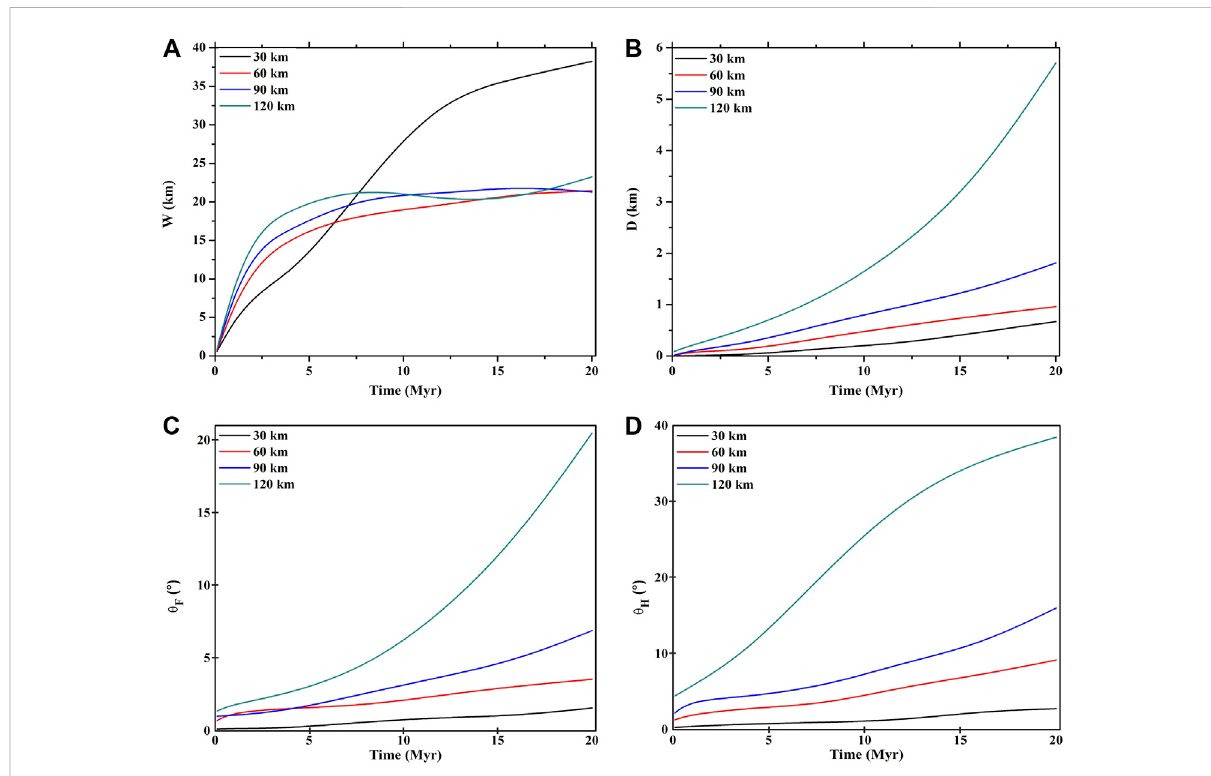
FIGURE 6 Time-dependentvariationsofthemajortopographicelementsoftrenches: (A) openingwidth(W), (B) maximumtrenchdepth(D), (C) FWslopes ( θ F), and (D) HW slopes ( θ H). The graph colors denote MDD values used in the simulation